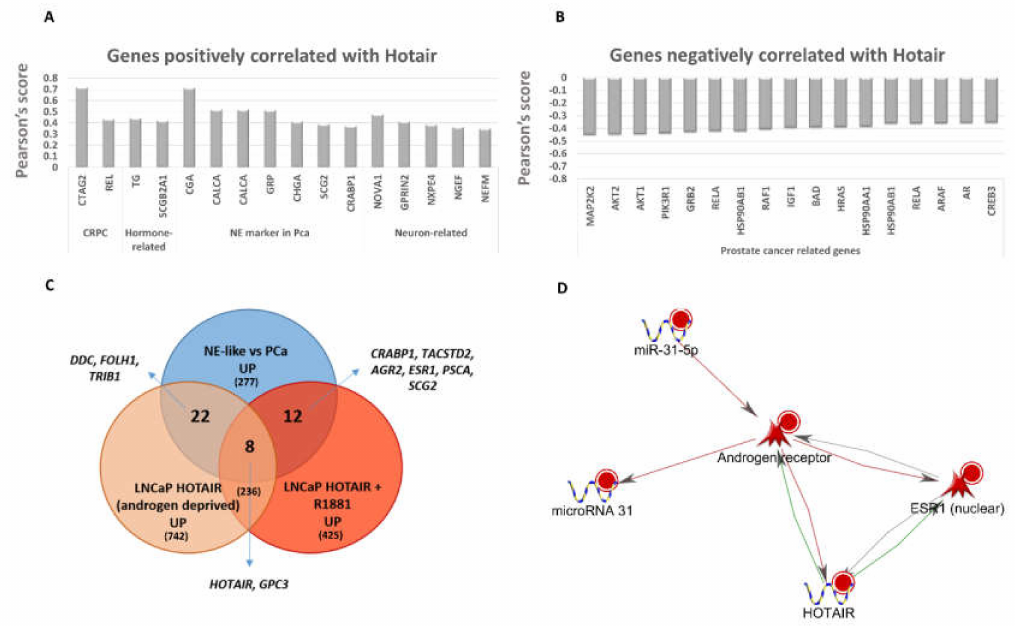
Figure 5. ( A ) Histogram depicting Pearson’s correlation coe ffi cient for a subset of genes whose expression was positively correlated with that of HOTAIR (Pearson score > 0.3 and p -value < 0.05). ( B ) Histogram depicting Pearson’s correlation coe ffi cient for a subset of prostate cancer-related genes whose expression was negatively correlated with that of HOTAIR (Pearson score < − 0.3 and p -value < 0.05). ( C ) Venn diagram of up-regulated genes in NE-like vs. AdenoPCa samples and in hormone-deprived LNCaP cells treated with HOTAIR alone or HOTAIR plus R1881, compared to correspondent controls, with extrapolation of some genes of interest. ( D ) Direct interaction network between AR, ESR1, HOTAIR and miR-31-5p. Red and green edges represent inhibition and activation mechanisms, respectively. Grey edges depict undefined / unknown